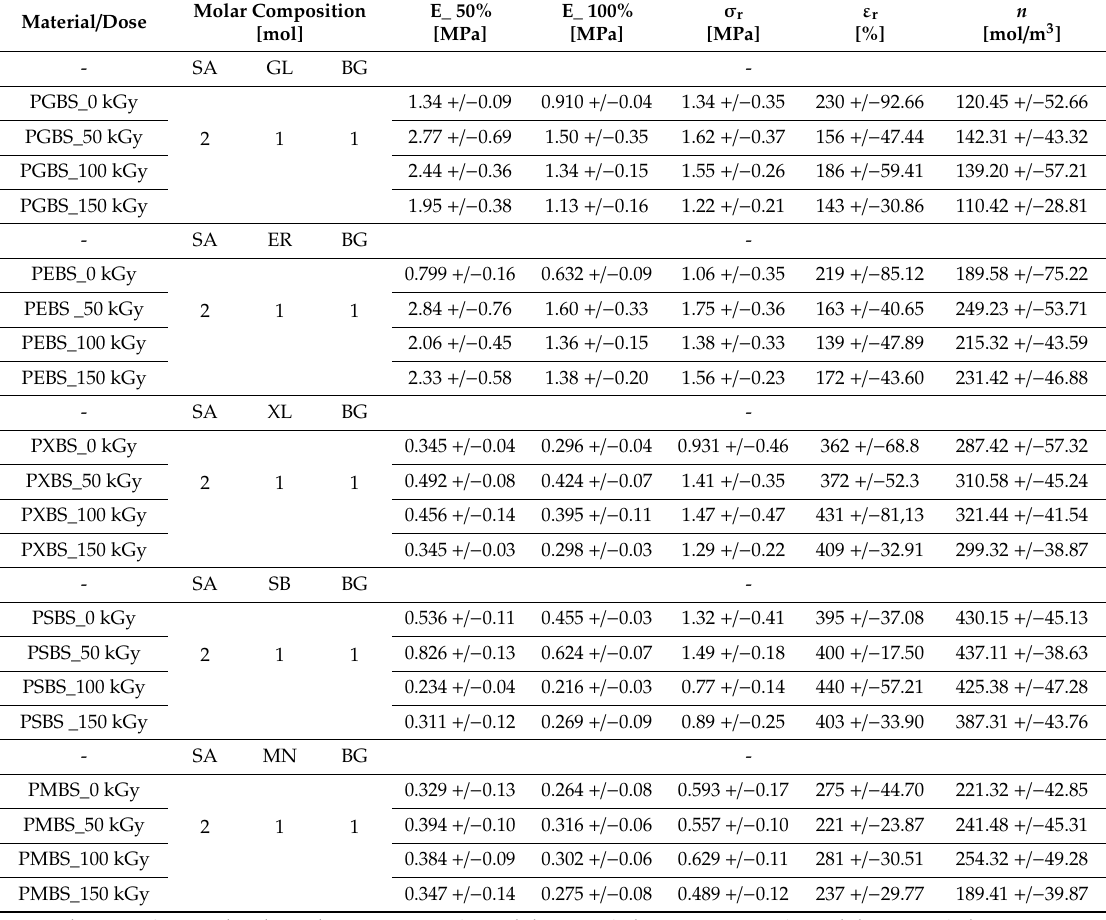
Table 2. Composition and selected properties of poly(glycerol sebacate-co-butylene sebacate) (PGBS), poly(erythritol sebacate-co-butylene sebacate) (PEBS), poly(xylitol sebacate-co-butylene sebacate) PXBS, poly(sorbitol sebacate-co-butylene sebacate) (PSBS),poly(mannitol sebacate-co-butylene sebacate) (PMBS) before and after